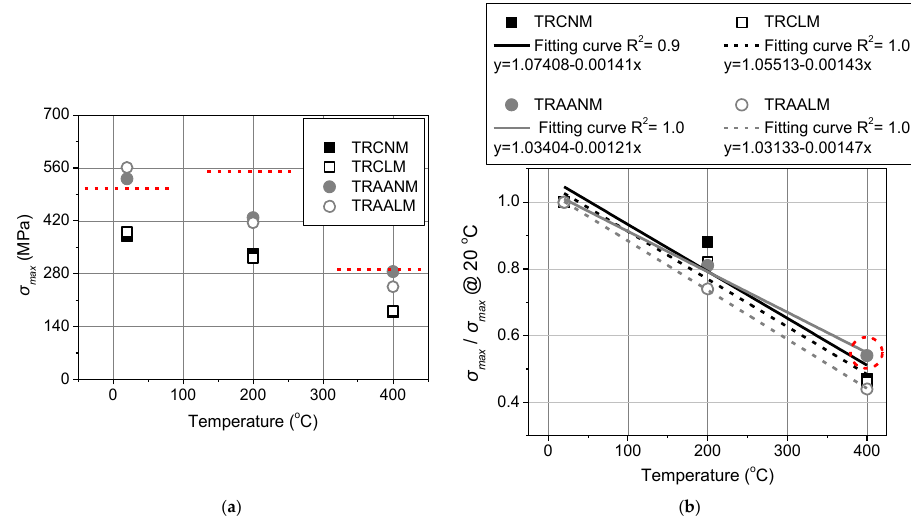
Figure 10. ( a ) The maximum textile axial stress ( σ max ) and ( b ) the ratio of the maximum textile axial stress of the heated to the reference SL/SP specimens versus elevated temperatures. The residual bond strength of TRM/masonry and TRAAM/masonry joints decreases as exposure temperature increases (Figure 10a). Specimens that were furnished with TRMs sharing the same binder exhibited (per exposure temperature) almost identical σ max values irrespective of their density class. Although not directly comparable (different